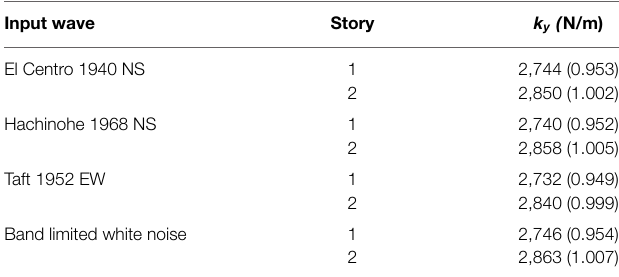
TABLE 5 | Identified value of horizontal stiffness in each story under various input